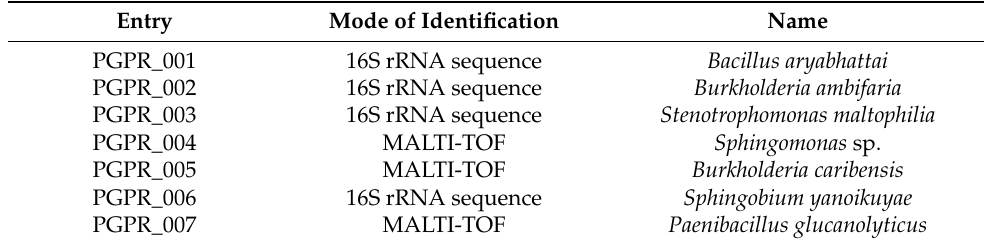
Table 1. Details of bacterial species and modes of identification. Entry Mode of Identification